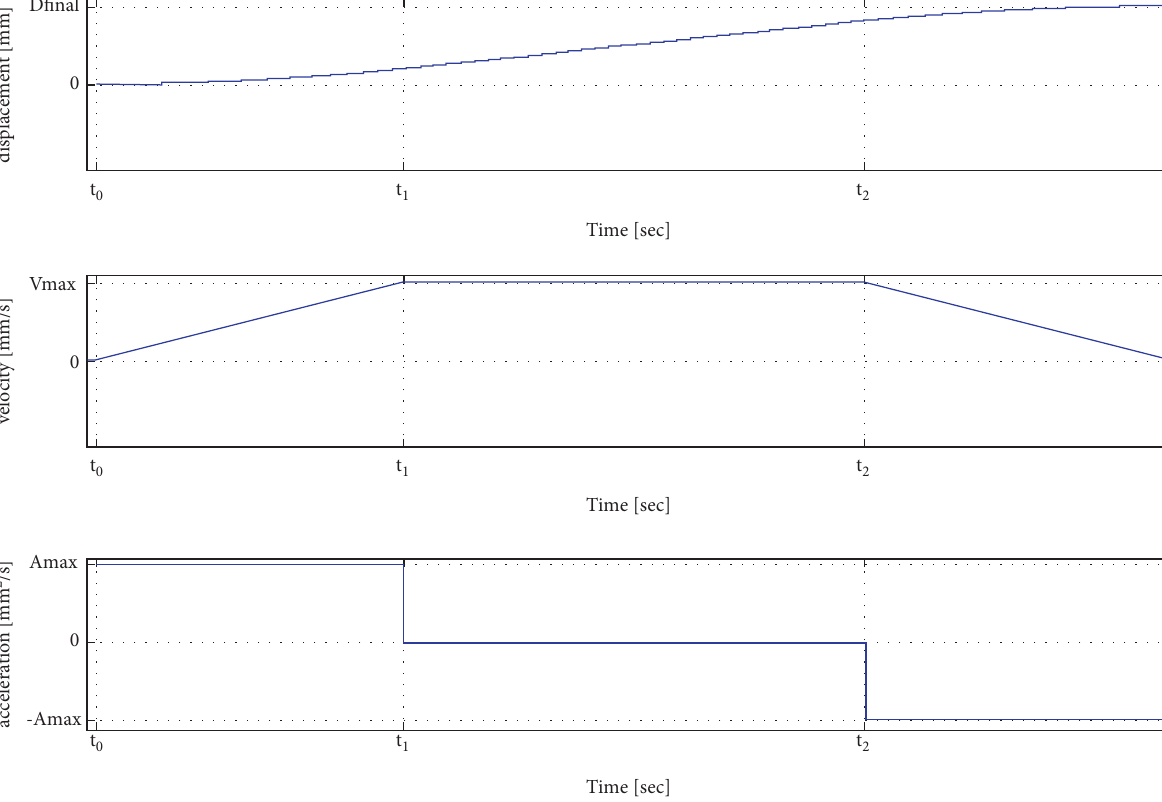
Figure 5: Motion profile of the velocity and acceleration in the trapezoidal strategy.